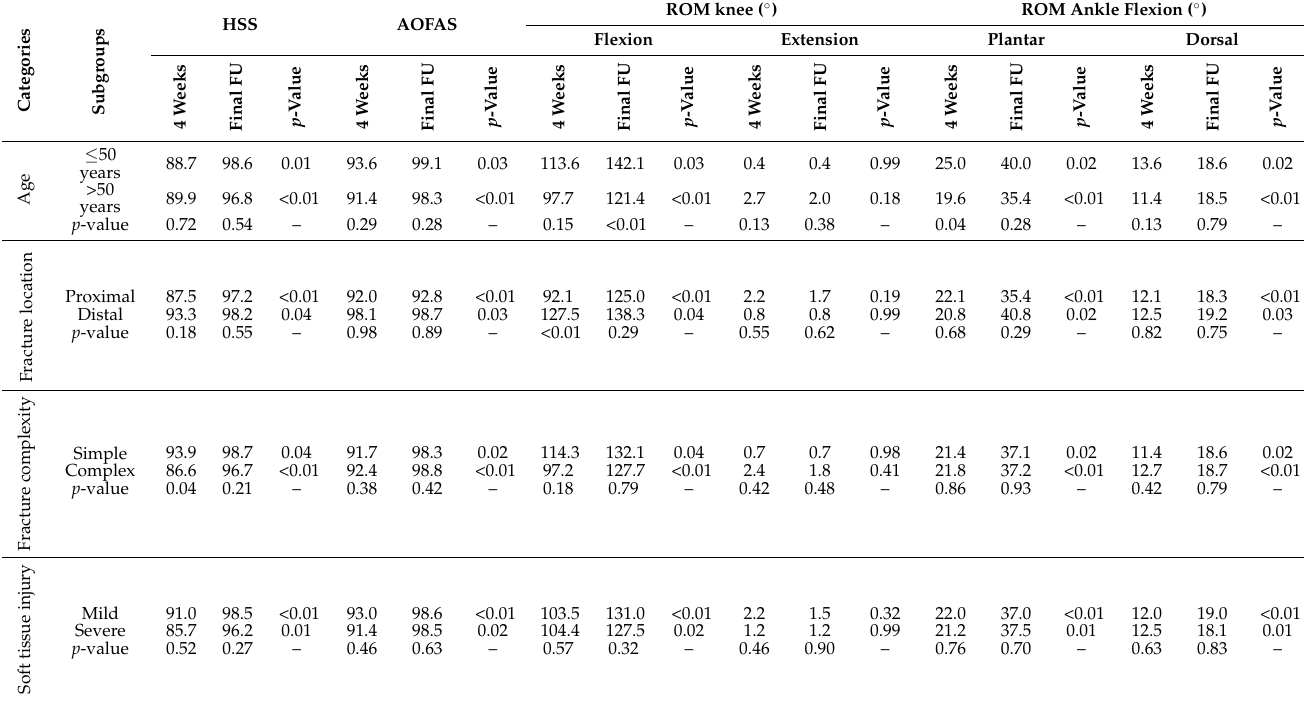
Table 3. Functional outcomes in the subgroups of patients according to the categories age, fracture location, fracture complexity, and soft tissue injury, presented in terms of mean value and p -values from the corresponding subgroups and time comparisons at the fourth week after surgery (4 weeks) and at the final follow-up (Final FU).